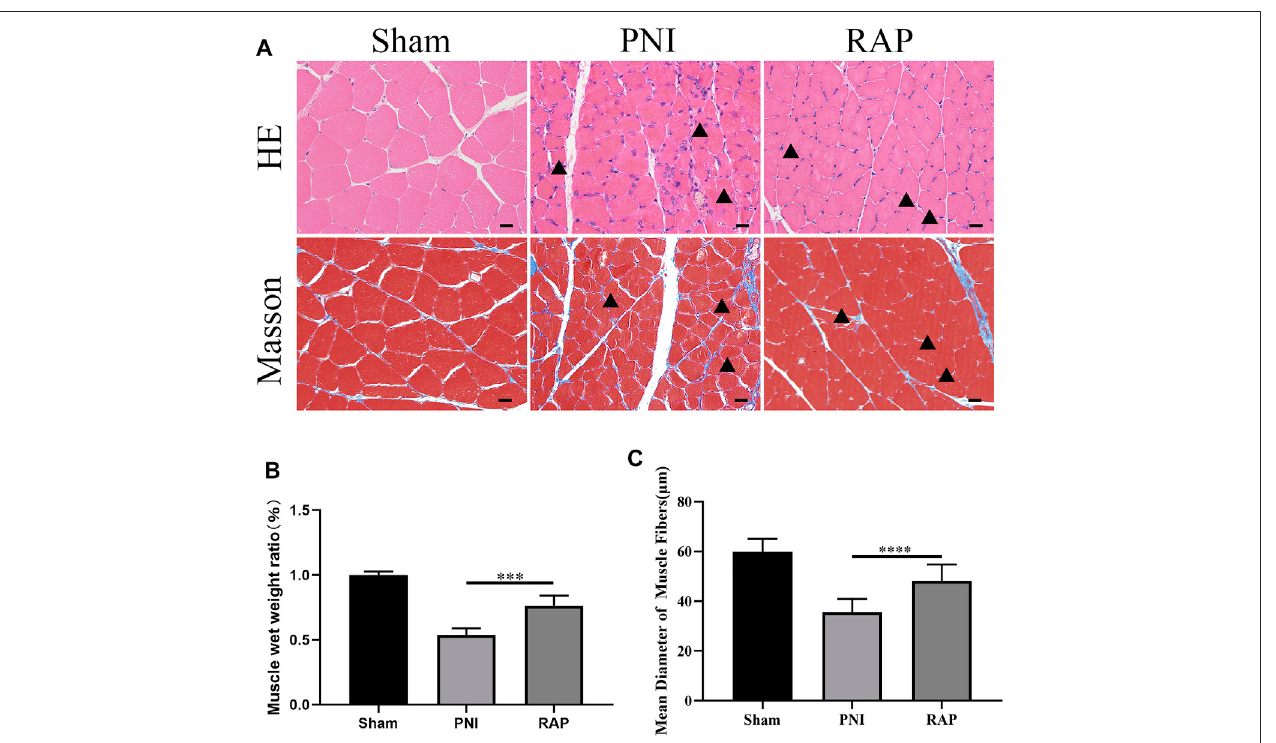
FIGURE 7 | RAP delayed gastrocnemius muscle atrophy after PNI (A) Representative HE and Masson staining images of gastrocnemius muscle transverse sections ineach group28 days after PNI (400× ampli fi cation, scale bar =20 μ m),arrows show atrophied muscle fi ber; (B) Statistical analysisofmuscle wet weightratio; (C) Statistical analysis of muscle fi ber mean diameter. Data are presented as means ± SD. *** p < 0.001, **** p <